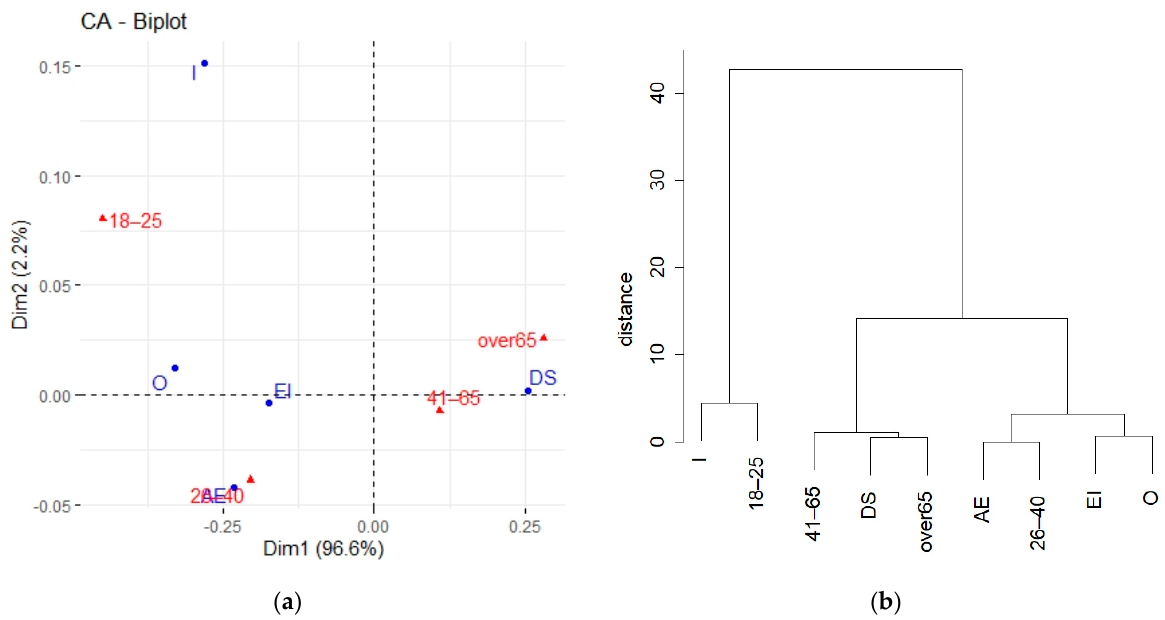
Figure 2. Correspondence map ( a ) and an auxiliary dendrogram ( b ) showing the dependence of each behavioural type of energy consumer on their age groups.